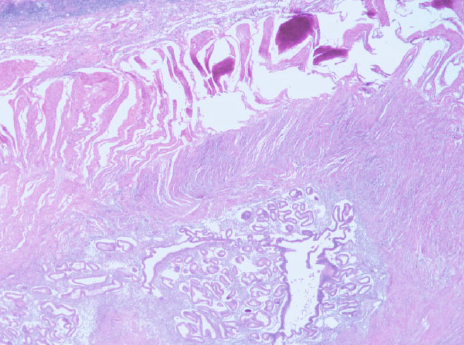
Figure 3: Endometriotic foci in the muscularis externa of the terminal ileum (H&E, 2x).